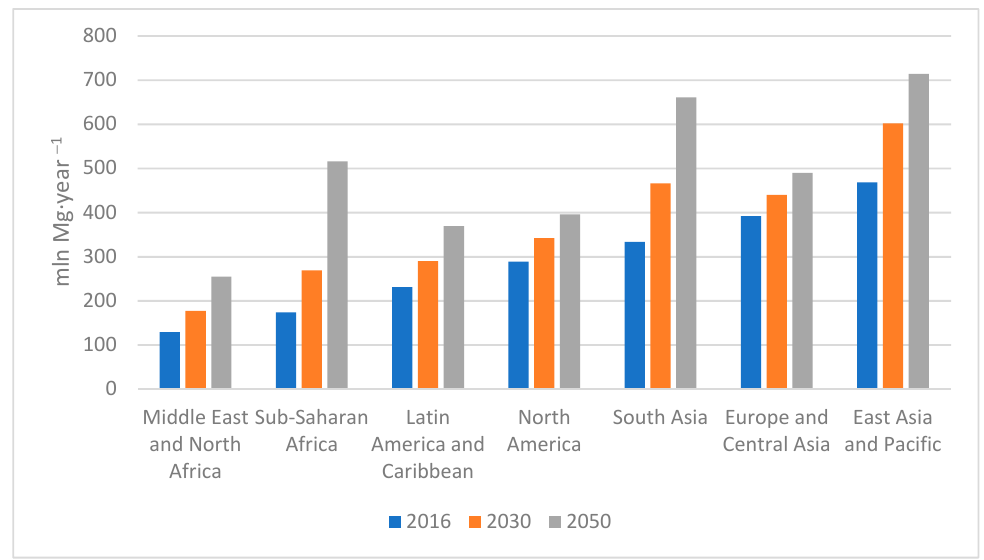
Figure 1. The amount of waste generated in the world in million tons [1].